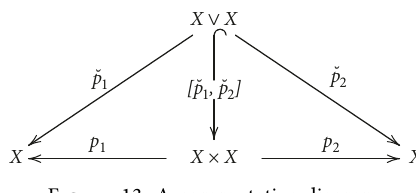
Figure 13: A commutative diagram.